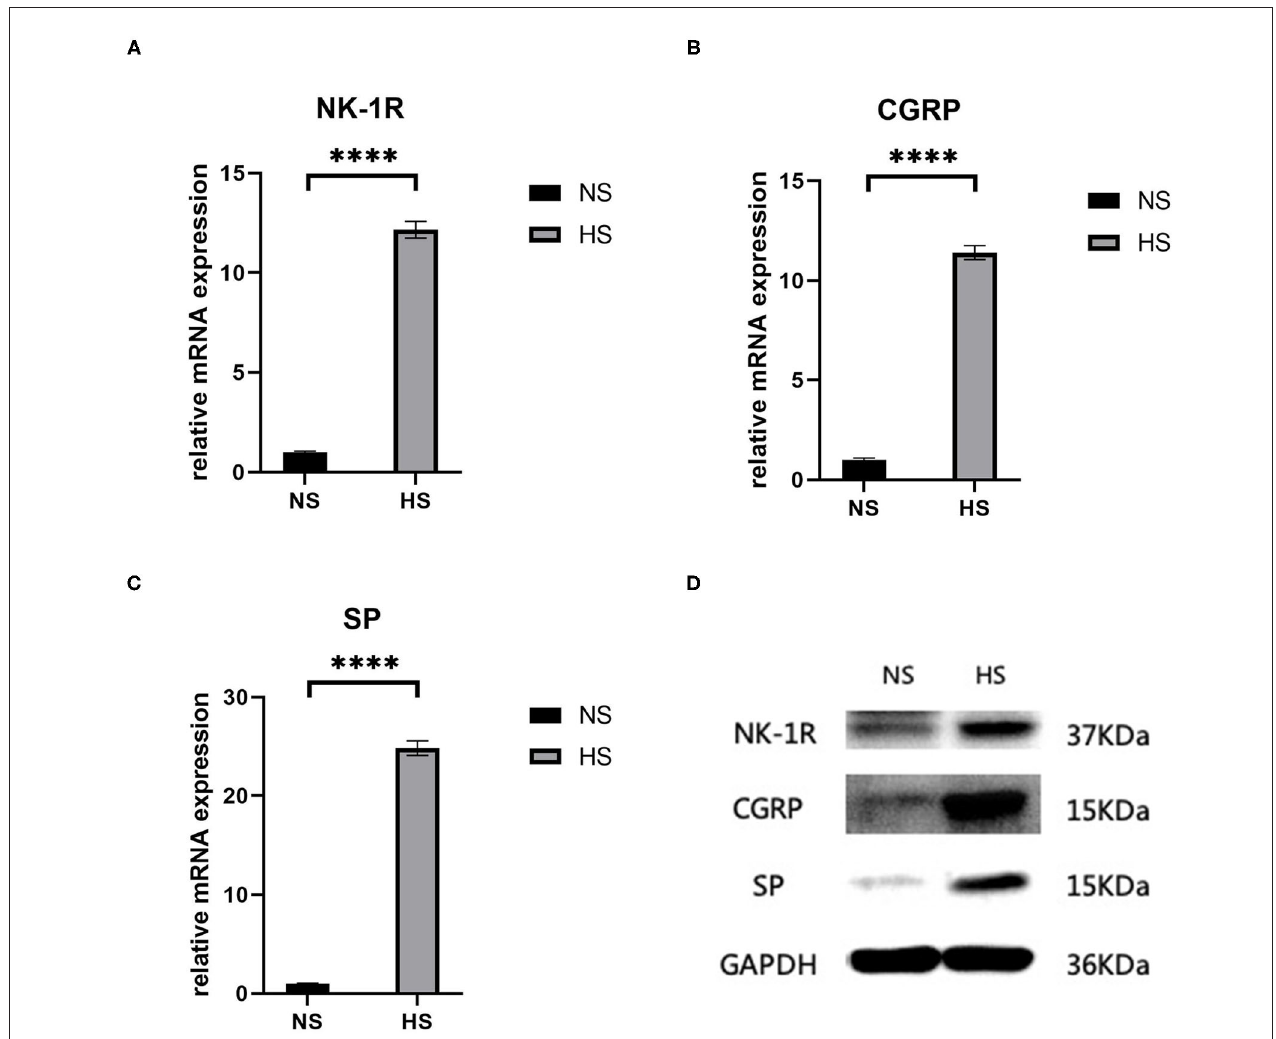
FIGURE 2 | (A) Relative mRNA expression of NK-1R in human hypertrophic scar and normal skin tissue samples; (B) Relative mRNA expression of CGRP in human hypertrophic scar and normal skin tissue samples; (C) Relative mRNA expression of SP in human hypertrophic scar and normal skin tissue samples; (D) Expression of NK-1R, CGRP, and SP in human hypertrophic scar and normal skin tissue samples detected by western blot analysis. The results are represented as the mean of 3 experiments ± SD, which were performed in duplicate for each experimental condition. NS, normal skin; HS, hypertrophic scar (**** P <